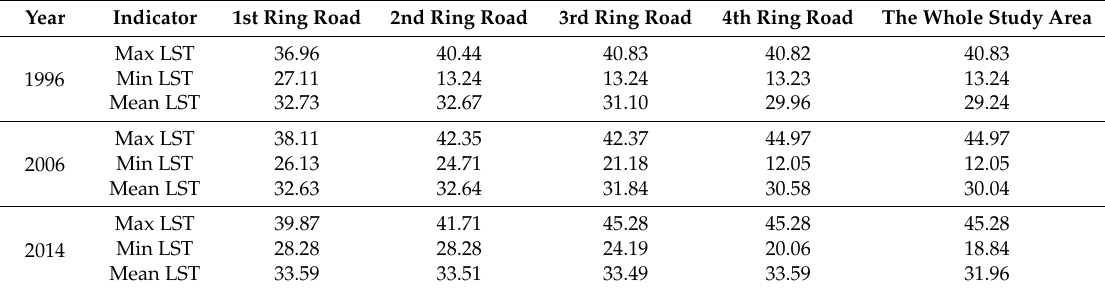
Table 5. LST values in the different Zhengzhou City ring road areas from 1996 to 2014 (unit: ◦